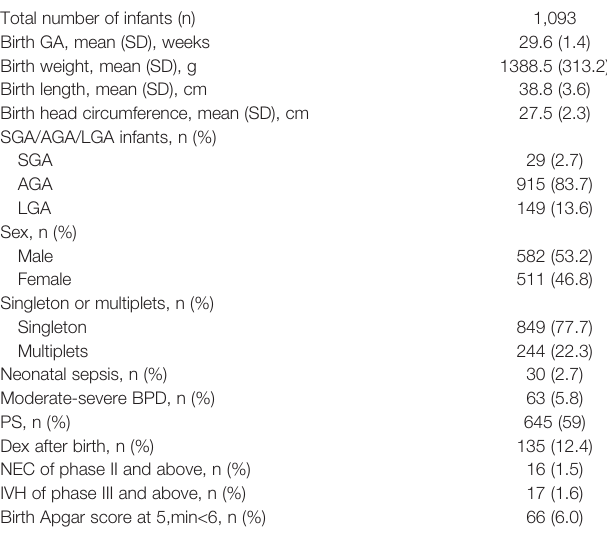
TABLE 1 | General characteristics of the study